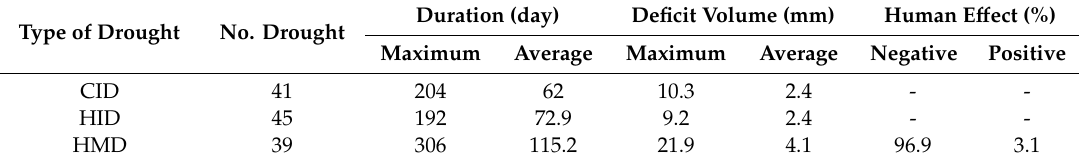
Table 4. Discharge drought characteristics for Eskandari (threshold = 80th percentile).